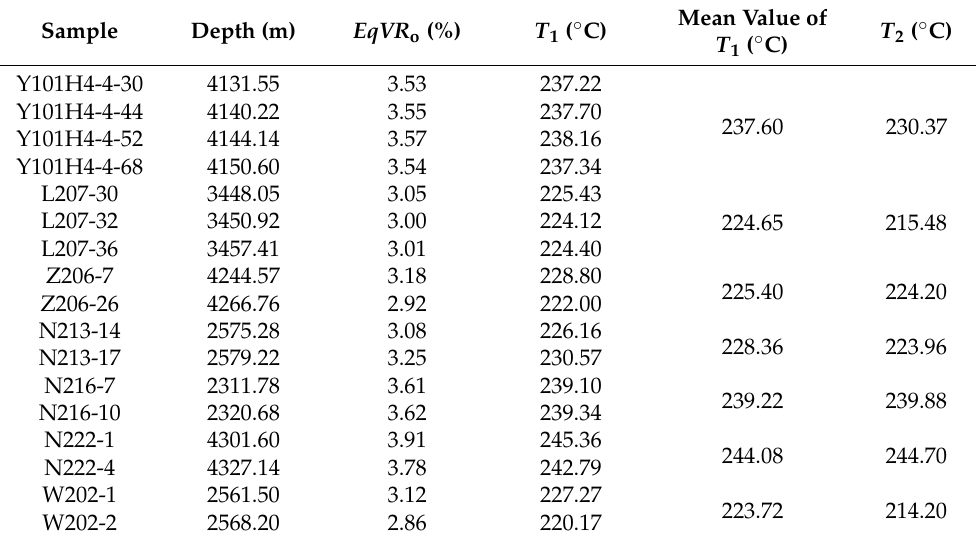
Table 3. Maximum paleo-temperatures estimation.